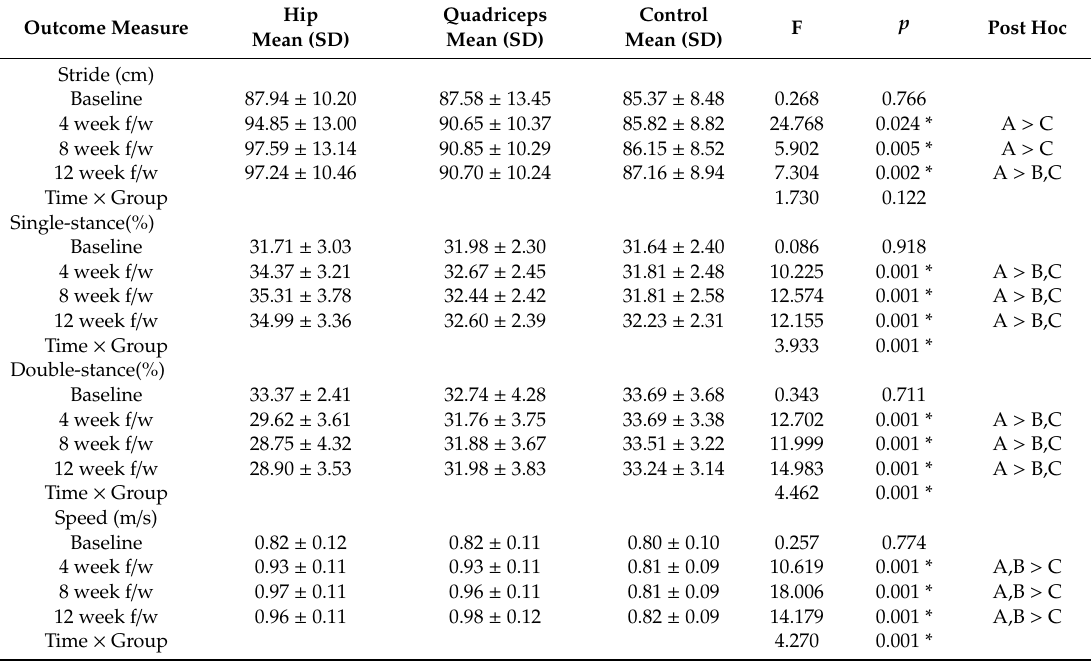
Table 6. Outcome scores for each group at baseline, post-treatment, 8 week follow-up, and 12 week follow-up: mean and standard deviation (gait